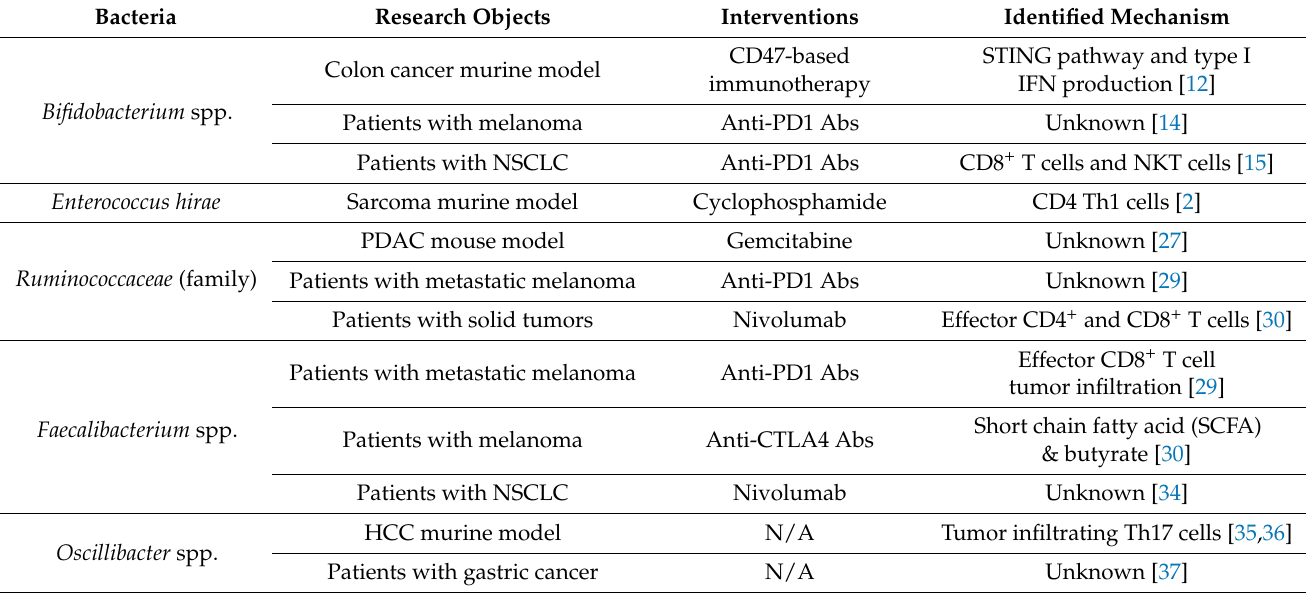
Table 1. The bacteria associated with favorable modulation in antitumor immunity. Bacteria Research Objects Interventions Identified Mechanism